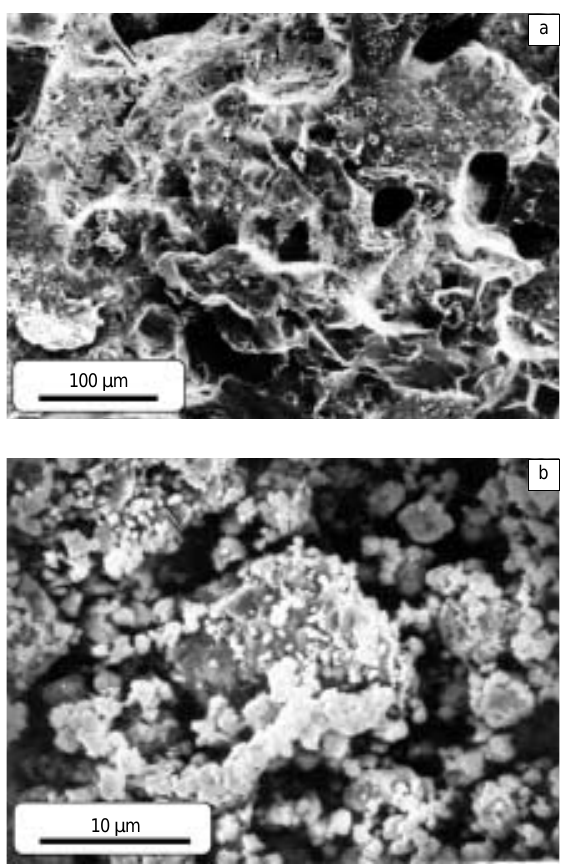
Fig. 9 Microphotograph of the SHS product in the system Ni 40.8 wt.% Al (a), the product of mechanical alloying in this system for 25